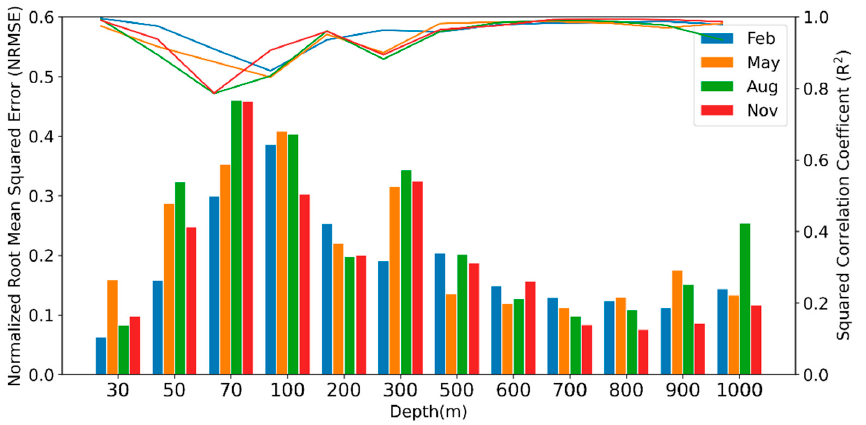
Figure 13. Performance measures by NRMSE and R 2 values of LGB-DF model for OSSS estimation at different depths in the SCS in 2019. Blue indicates February (winter), orange indicates May (spring), green indicates August (summer), red indicates November (autumn), the histograms display the NRMSE, and the lines display R 2 .